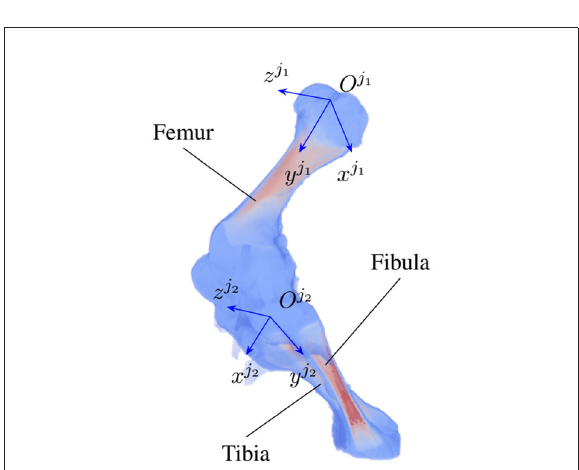
FIGURE2 An example of joint coordinate systems of a piglet hindlimb with two major bones (femur and tibia). Each local coordinate system is represented by three axes { x j i , y j i , z j i } which are the vertical, longitudinal, and transverse axis of joint j i , i = 1,2, respectively.